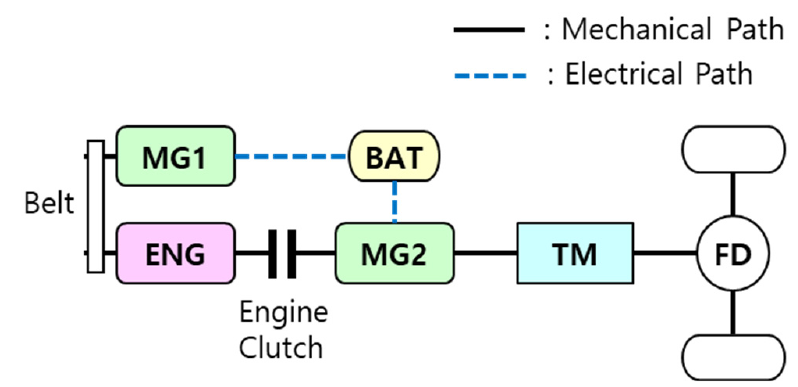
Figure 1. Powertrain structure of the target vehicle.